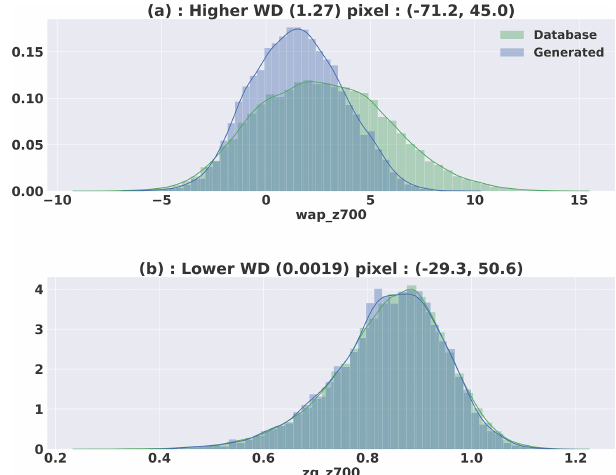
Figure 17. Distributions with the higher (a) and lower (b) Wasser- stein distances computed on normalized data. The coordinates of corresponding pixels are, respectively, in latitude and longitude.